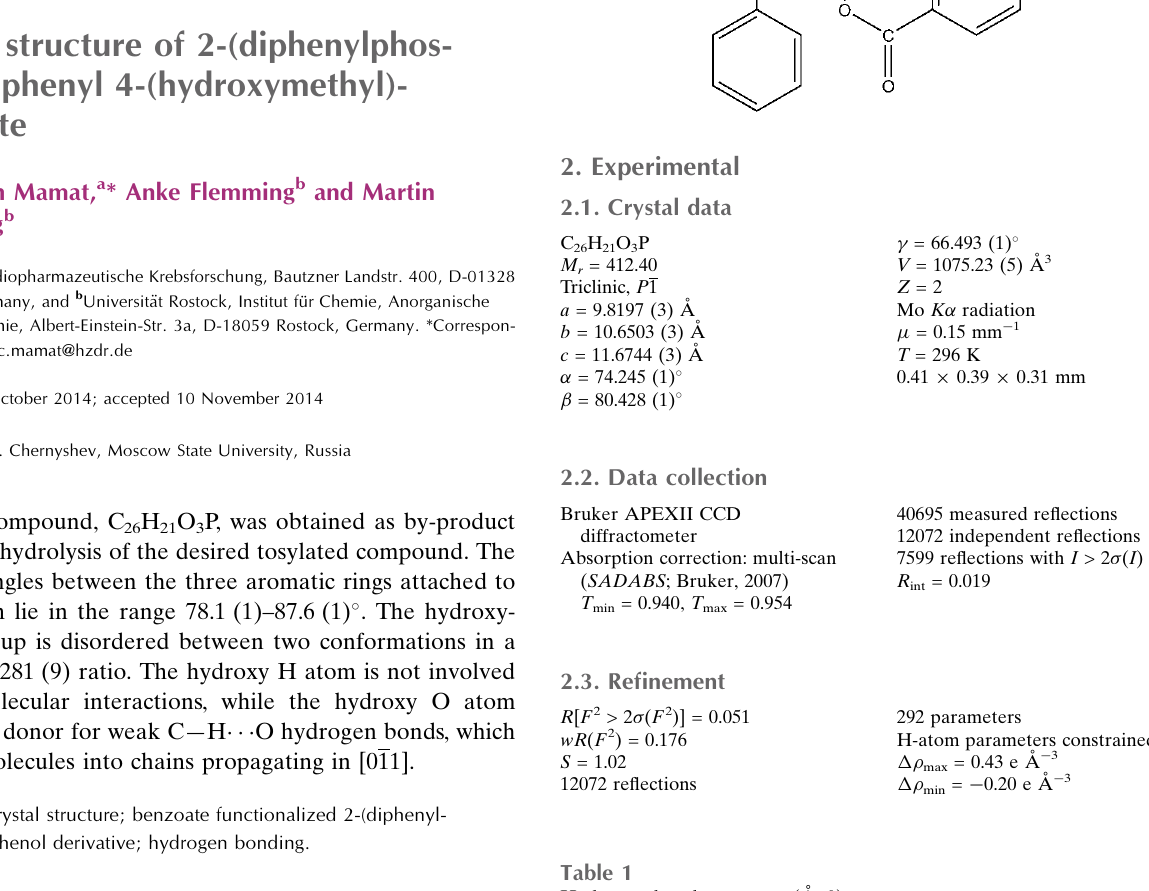
Hydrogen-bond geometry (A˚ , (cid:2)